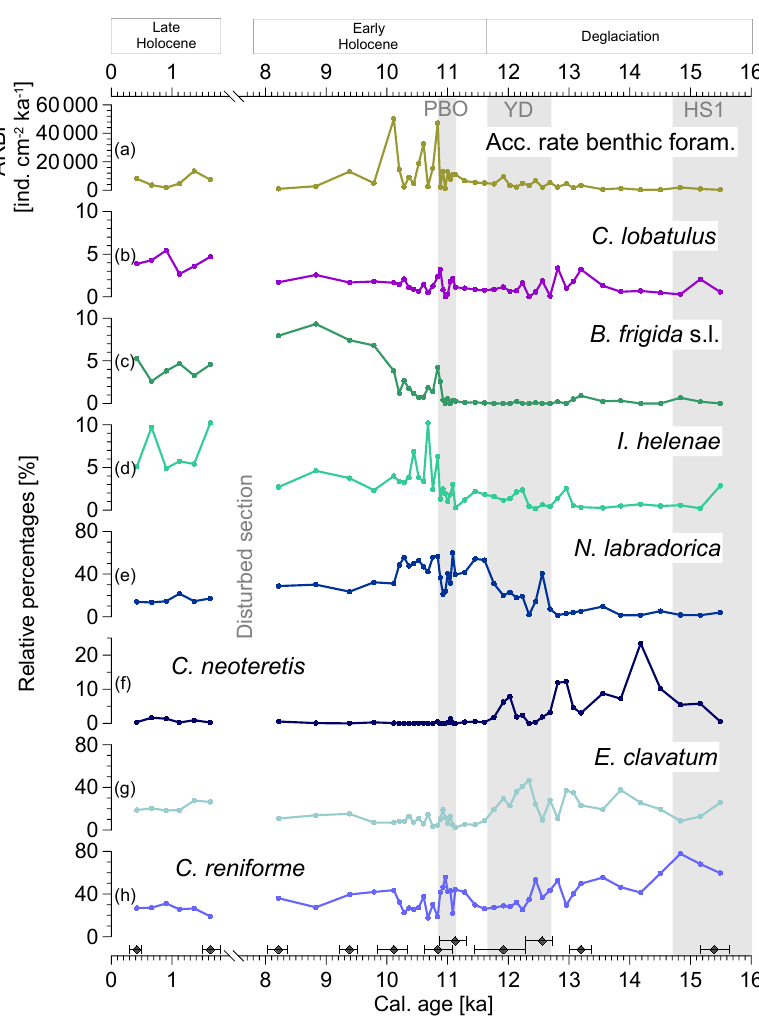
Figure 5. (a) Accumulation rates of benthic foraminifera (ARBFs) and (b–h) relative percentages of dominant calcareous benthic foraminifera. (b) Cibicides lobatulus . (c) Buccella frigida s.l. (d) Islandiella helenae . (e) Nonionellina labradorica . (f) Cassidulina neoteretis . (g) Elphidium clavatum . (h) Cassidulina reniforme . Grey vertical shadings; see Fig. 4. Dark grey diamonds: calibrated radiocarbon ages with error